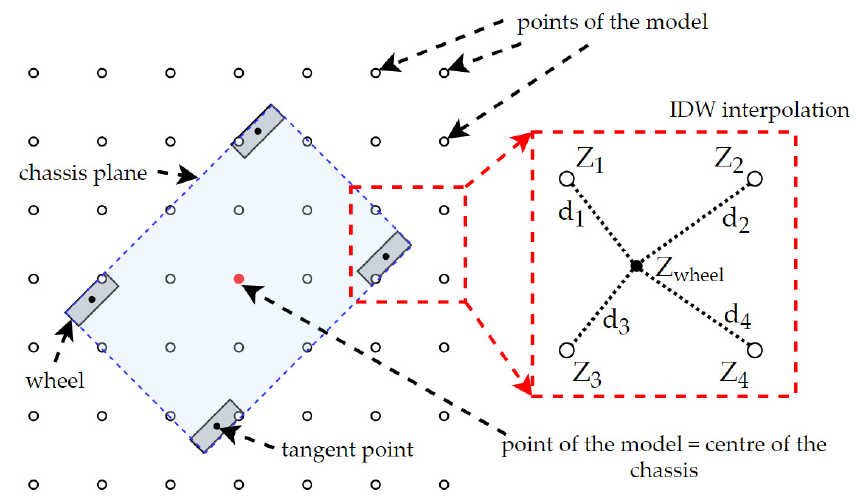
Figure 7. The conception of the inverse distance weighted (IDW) interpolation.